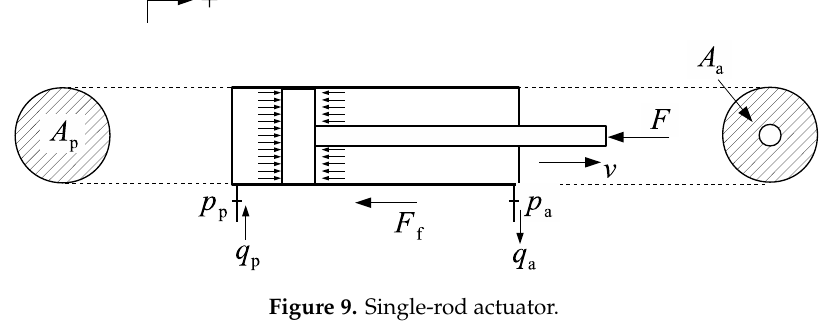
Figure 9. Single-rod actuator.